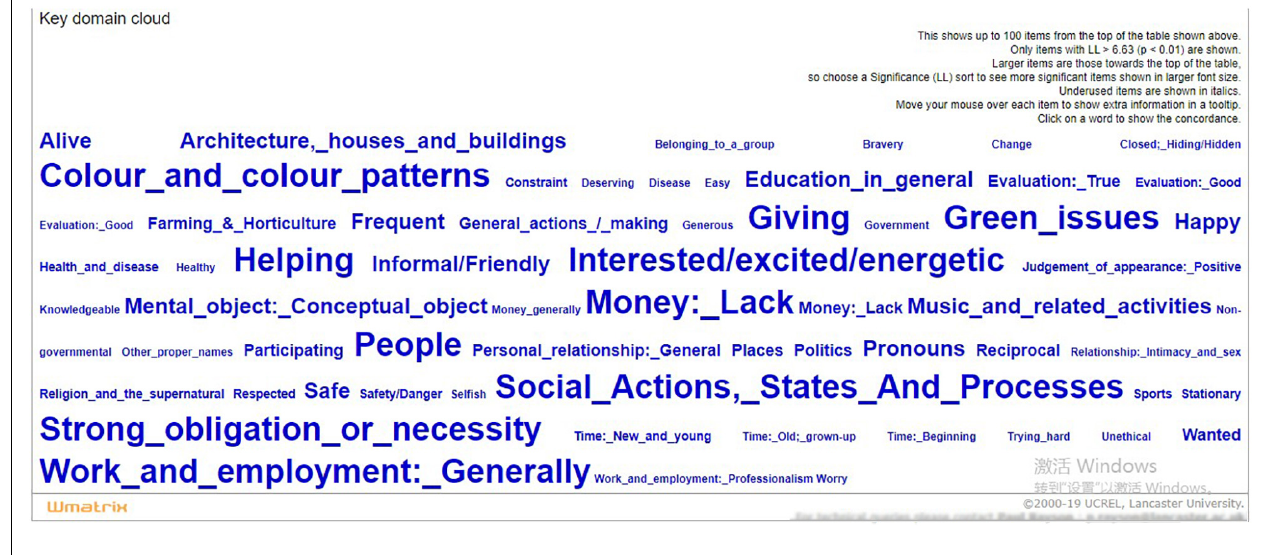
FIGURE 2 | Key semantic domain cloud of the corporate social responsibility (CSR) report CEO